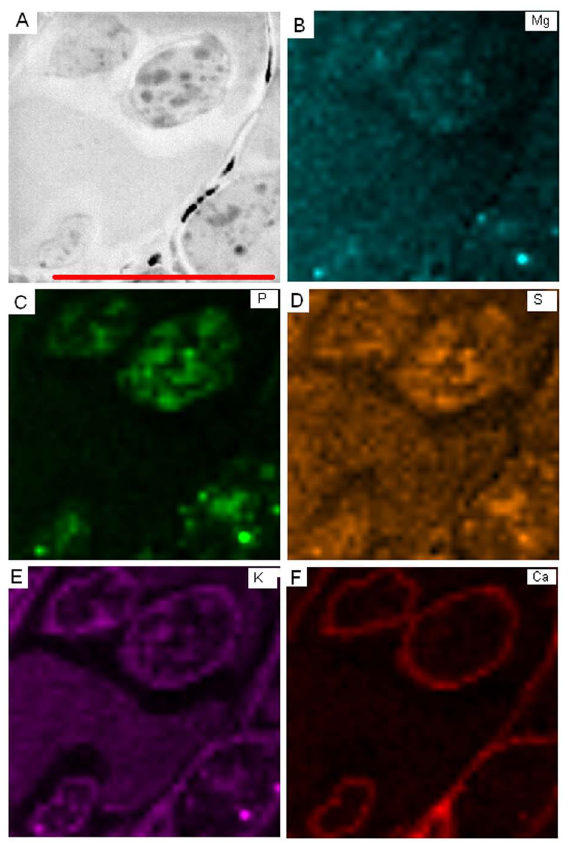
Fig. 3. EDX-STEM-mapping of arbuscular mycorrhizal root of ash ( Fraxinus excelsior ) colonized by Glomus sp. EDX-STEM-mapping of 40 6 40 measurement points in the area depicted (A) of magnesium (B, turquoise), phosphorus (C, green), sulphur (D, orange), potassium (E, purple), and calcium (F, red). Scale bar: 10 m m.